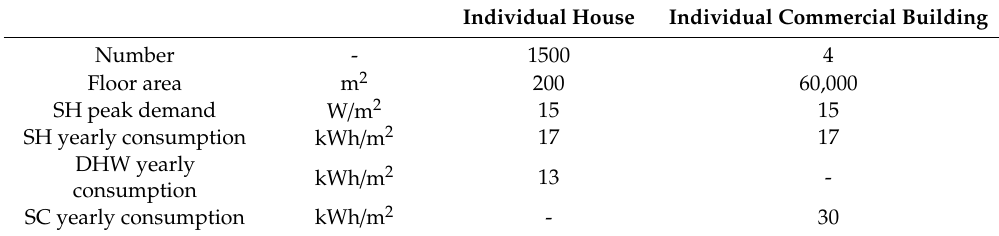
Table 3. Energy demand data for the